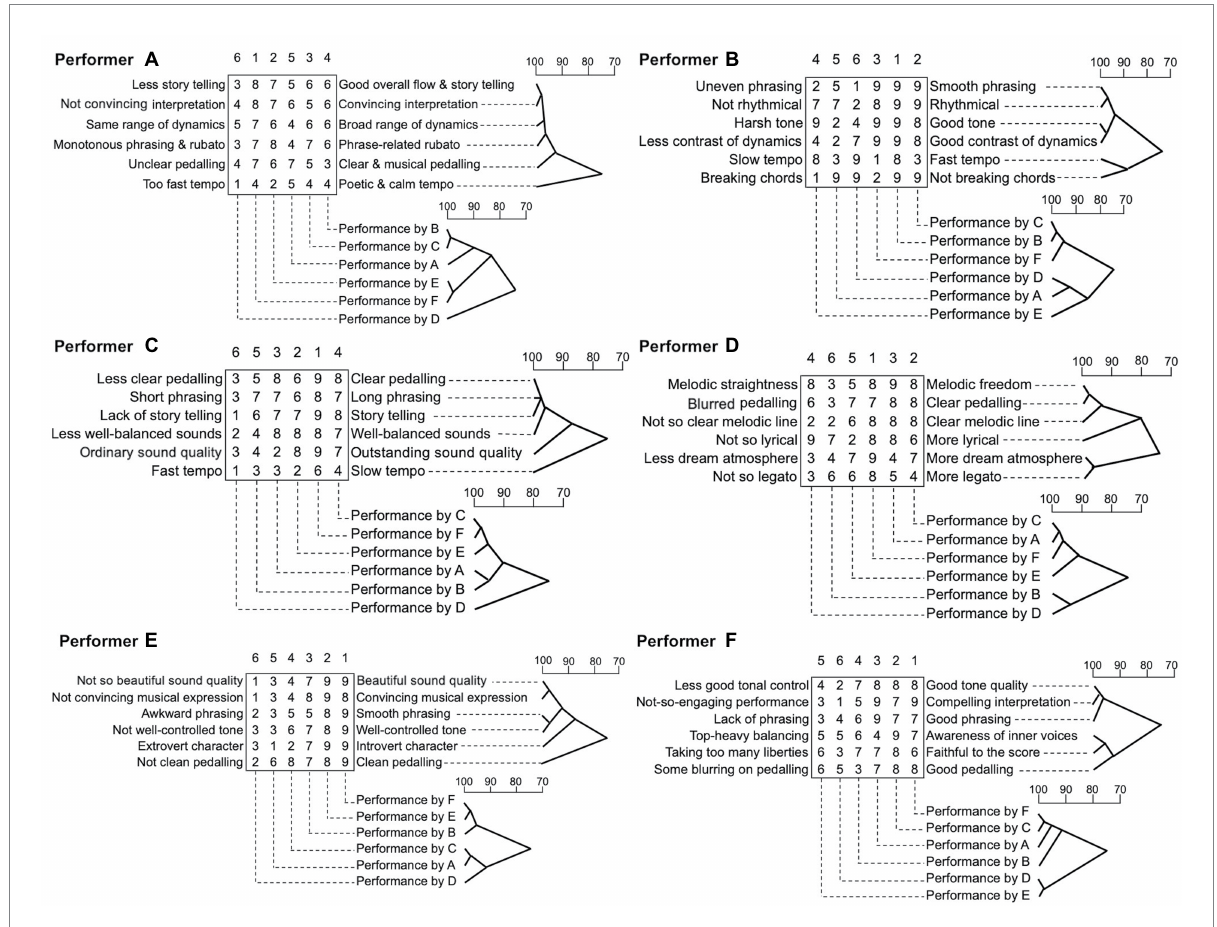
FIGURE 3 Clusters of performers’ evaluations of the performances of